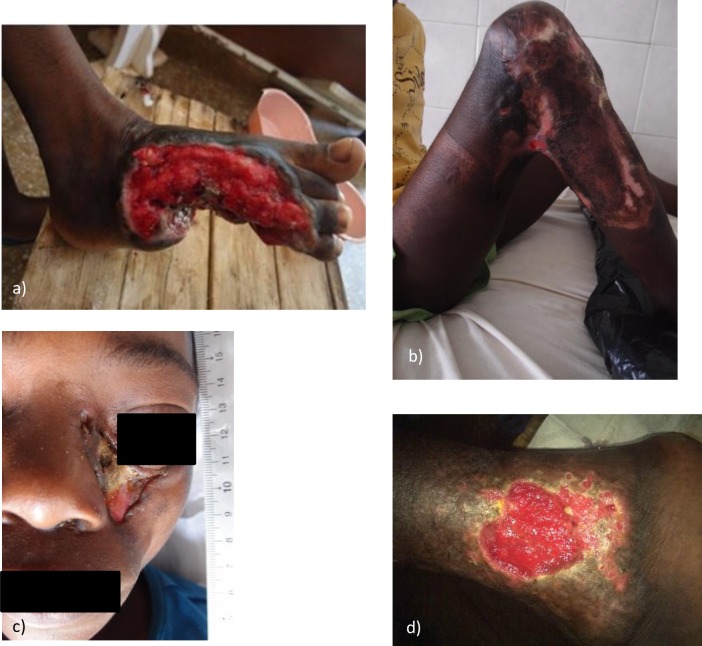
Complications of IS2404 PCR positive ulcers a) squamous cell carcinoma of the right foot in patient 023 at the SHC center b) knee contracture in patient 014 at the SHC center; c) exposed necrotic maxillary bone in patient 015 at the SHC center d) non-healing left lateral malleolar ulcer with underlying chronic lymphedema in patient 007 at the PHC center.